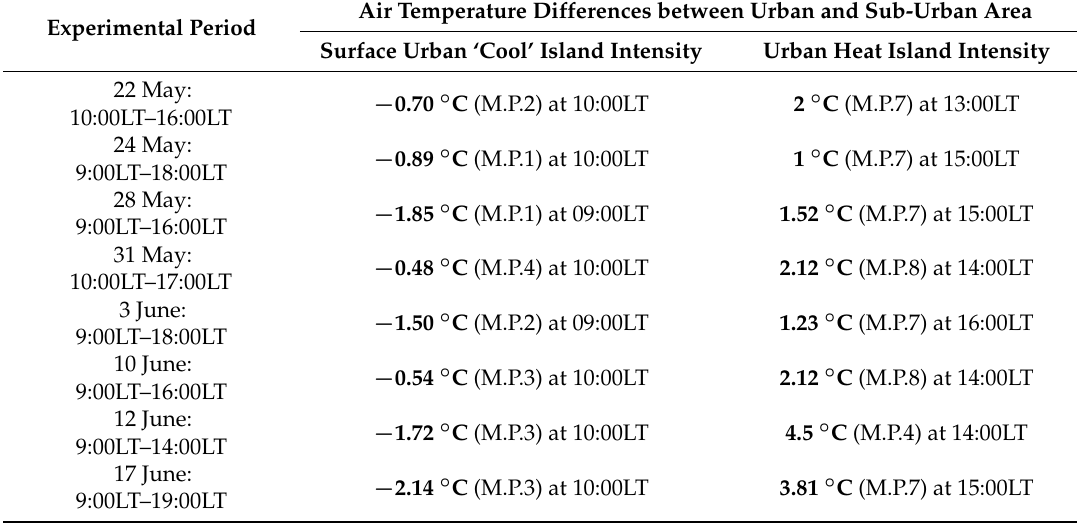
Table 2. Maximum air temperature differences between urban and sub-urban measurements. Air Temperature Differences between Urban and Sub-Urban Area Experimental Period Surface Urban ‘Cool’ Island Intensity Urban Heat Island